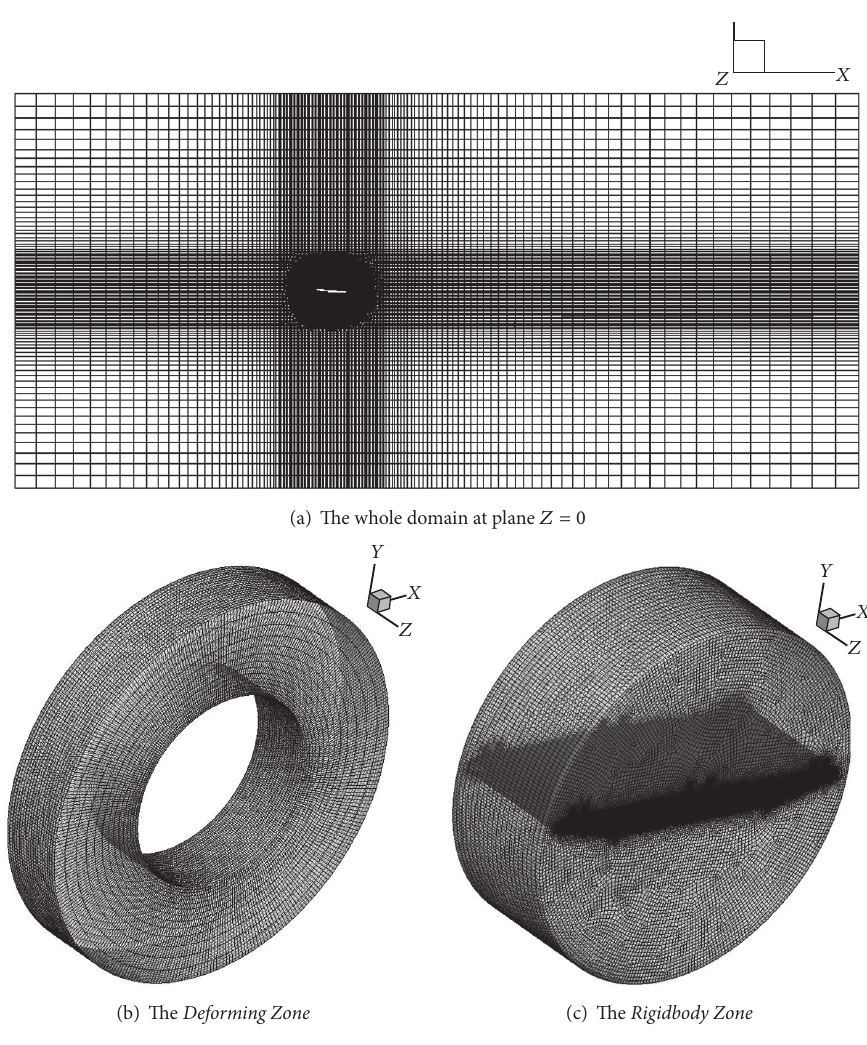
Figure 8: Mesh distributions of Case #0 at attack angle +5 ∘